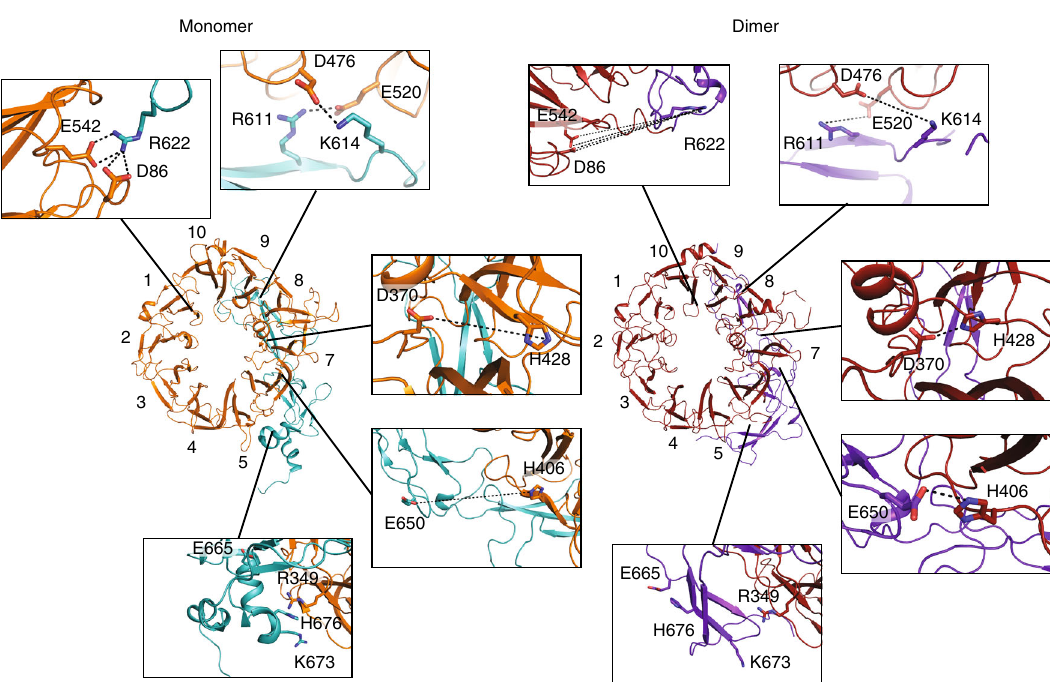
Fig. 3 Different charge-dependent salt bridges stabilize the monomer and dimer conformation of s-sortilin. Monomer β -propeller represented in orange and 10CC domains (PDB 3F6K) in light blue; dimer β -propeller represented in red and 10CC domains in purple. Interacting residues are shown in sticks. Three salt bridges stabilize the monomer structure (two top panels at the left) while these interactions are broken and the involved residues have moved apart in the dimer structure (two top panels at the right) (distances > 7.1 Å; middle two panels). On the other hand, two salt bridges in the dimer (two middle panels at the right) are disrupted and far apart in the monomer (two middle panels at the left). These new salt bridges in the dimer are enabled by the protonation of H406 and H428 at acidic pH. Interestingly, protonation of H676 (bottom panels) would lead to a coulombic clash between the β -propeller and the 10CC-b domain in the monomer structure (left), while after rearrangement H676 takes part in a charged interaction with E665, away from the β -propeller